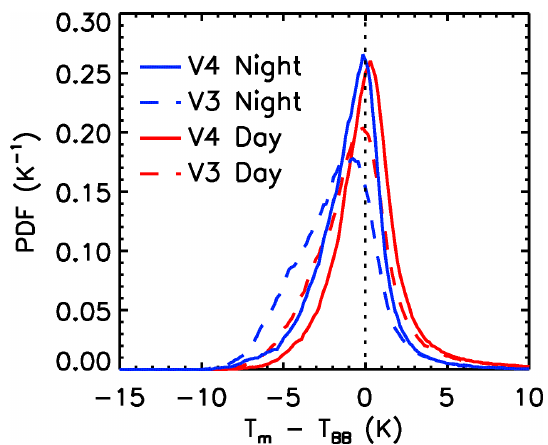
Figure 8. Probability density functions of the V4 (solid) and V3 (dashed) nighttime (blue) and daytime (red) differences between measured brightness temperature and computed blackbody bright- ness temperatures over oceans between 60 ◦ S and 60 ◦ N in Jan- uary 2008 for the IIR 12.05µm